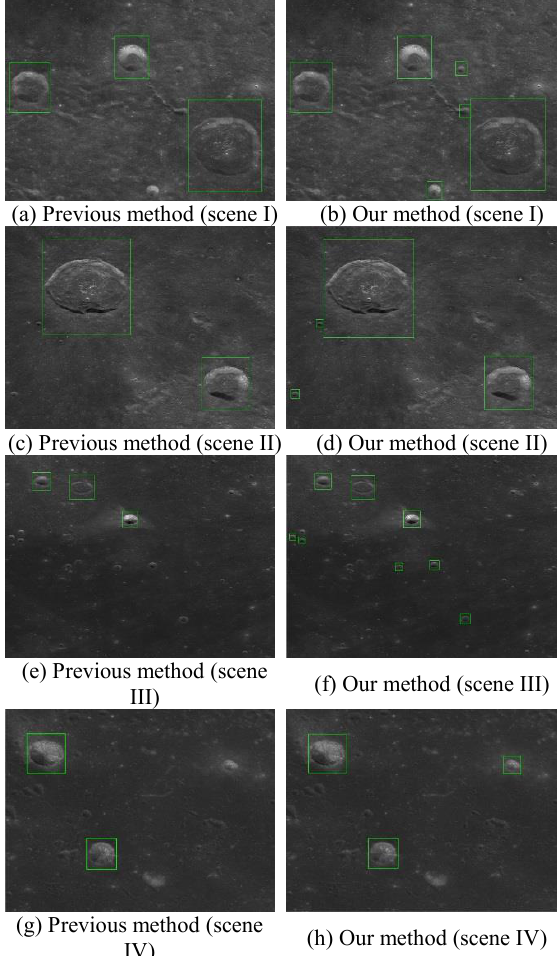
Figure 10 Result comparison between different methods